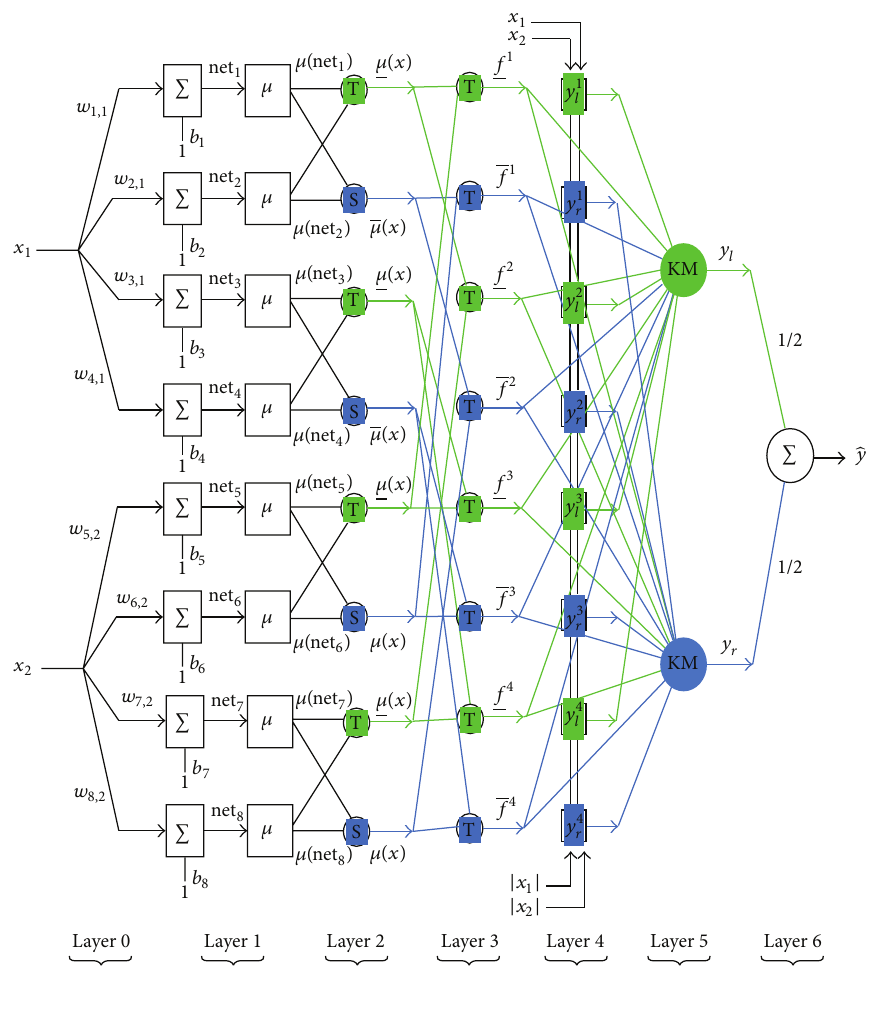
Figure 4: IT2FNN-2 architecture.